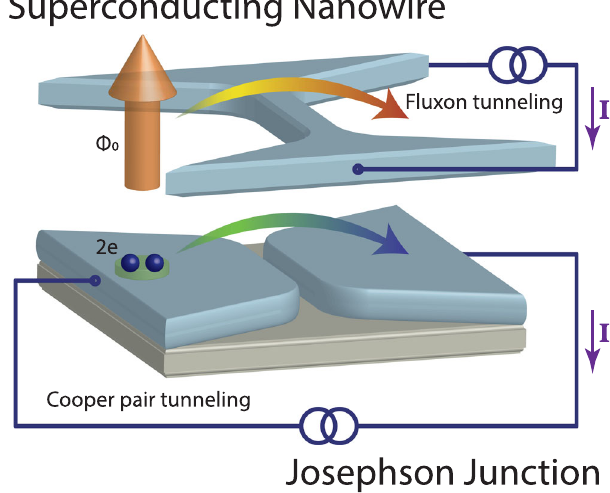
Fig. 1 Flux-charge duality. Quantum tunneling of a magnetic fl uxon Φ 0 across a superconducting nanowire and a dual tunneling process of a Cooper pair with charge 2 e across a Josephson junction between two